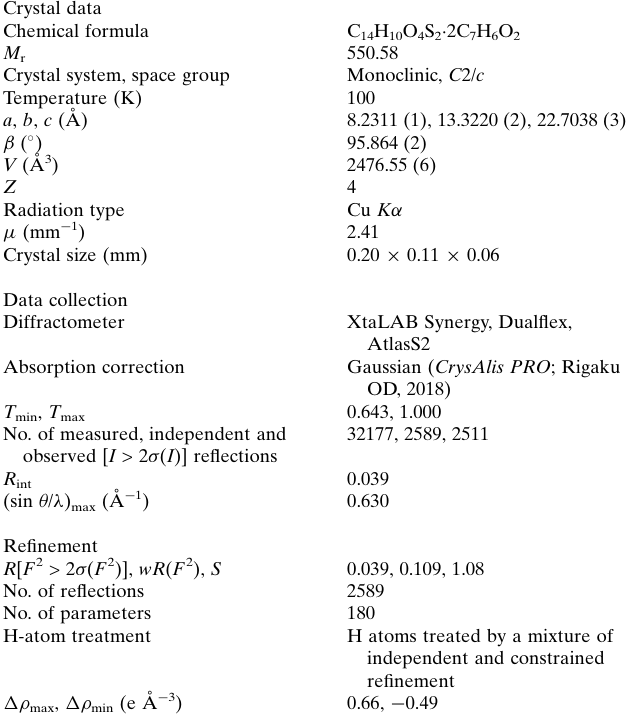
Table 4 Experimental details. Crystal data Chemical